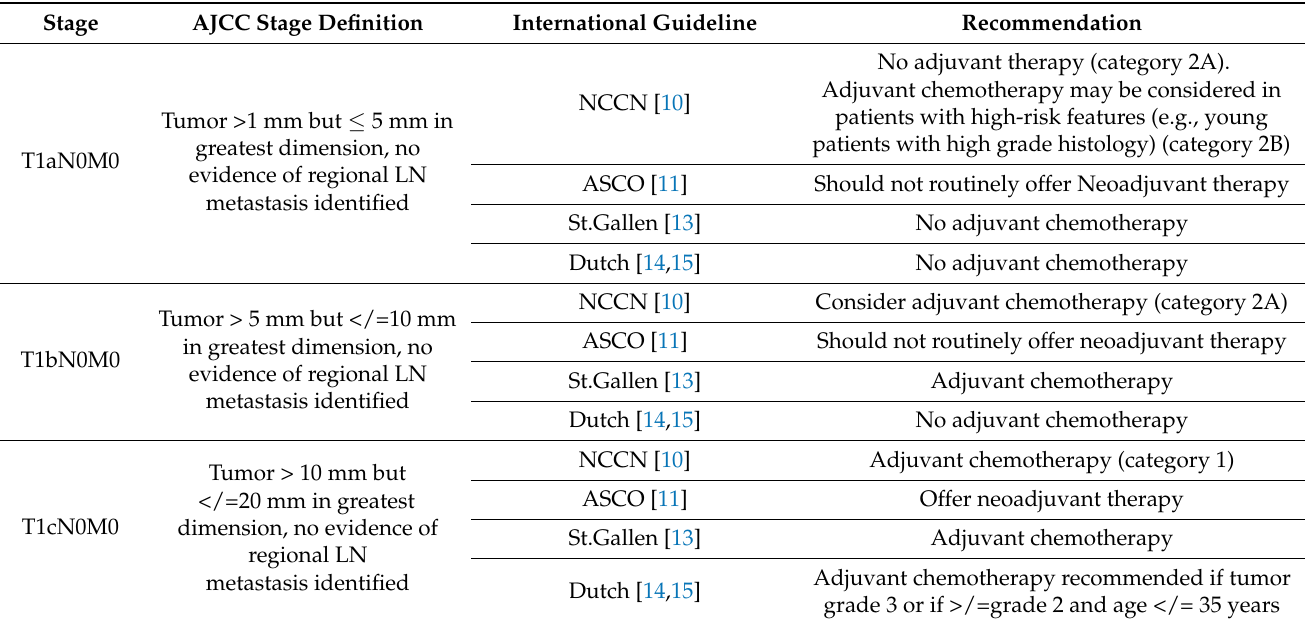
Table 1. Adjuvant/Neoadjuvant chemotherapy recommendations for stage I TNBC according to various international